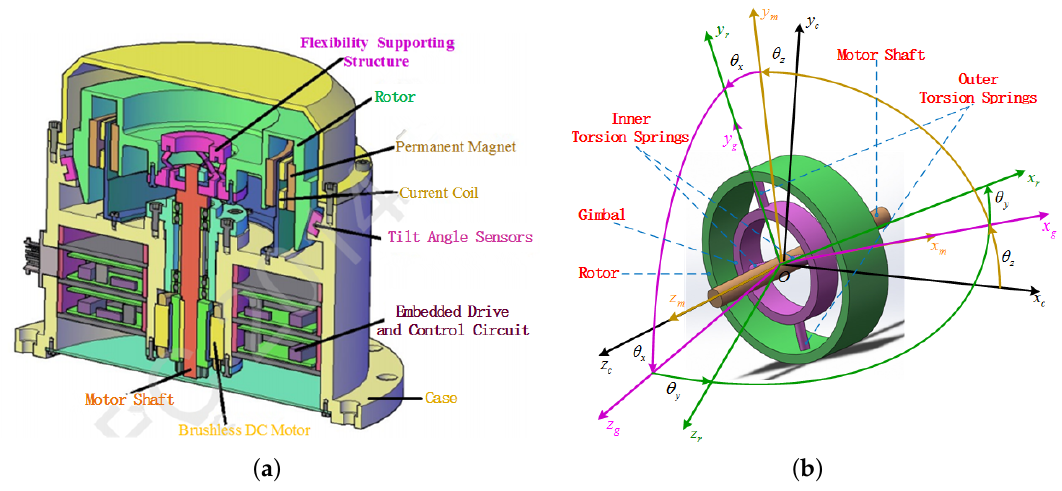
Figure 1. GW physical structure. ( a ) Schematic diagram of a gyrowheel system; ( b ) Simplified gyrowheel structure diagram.